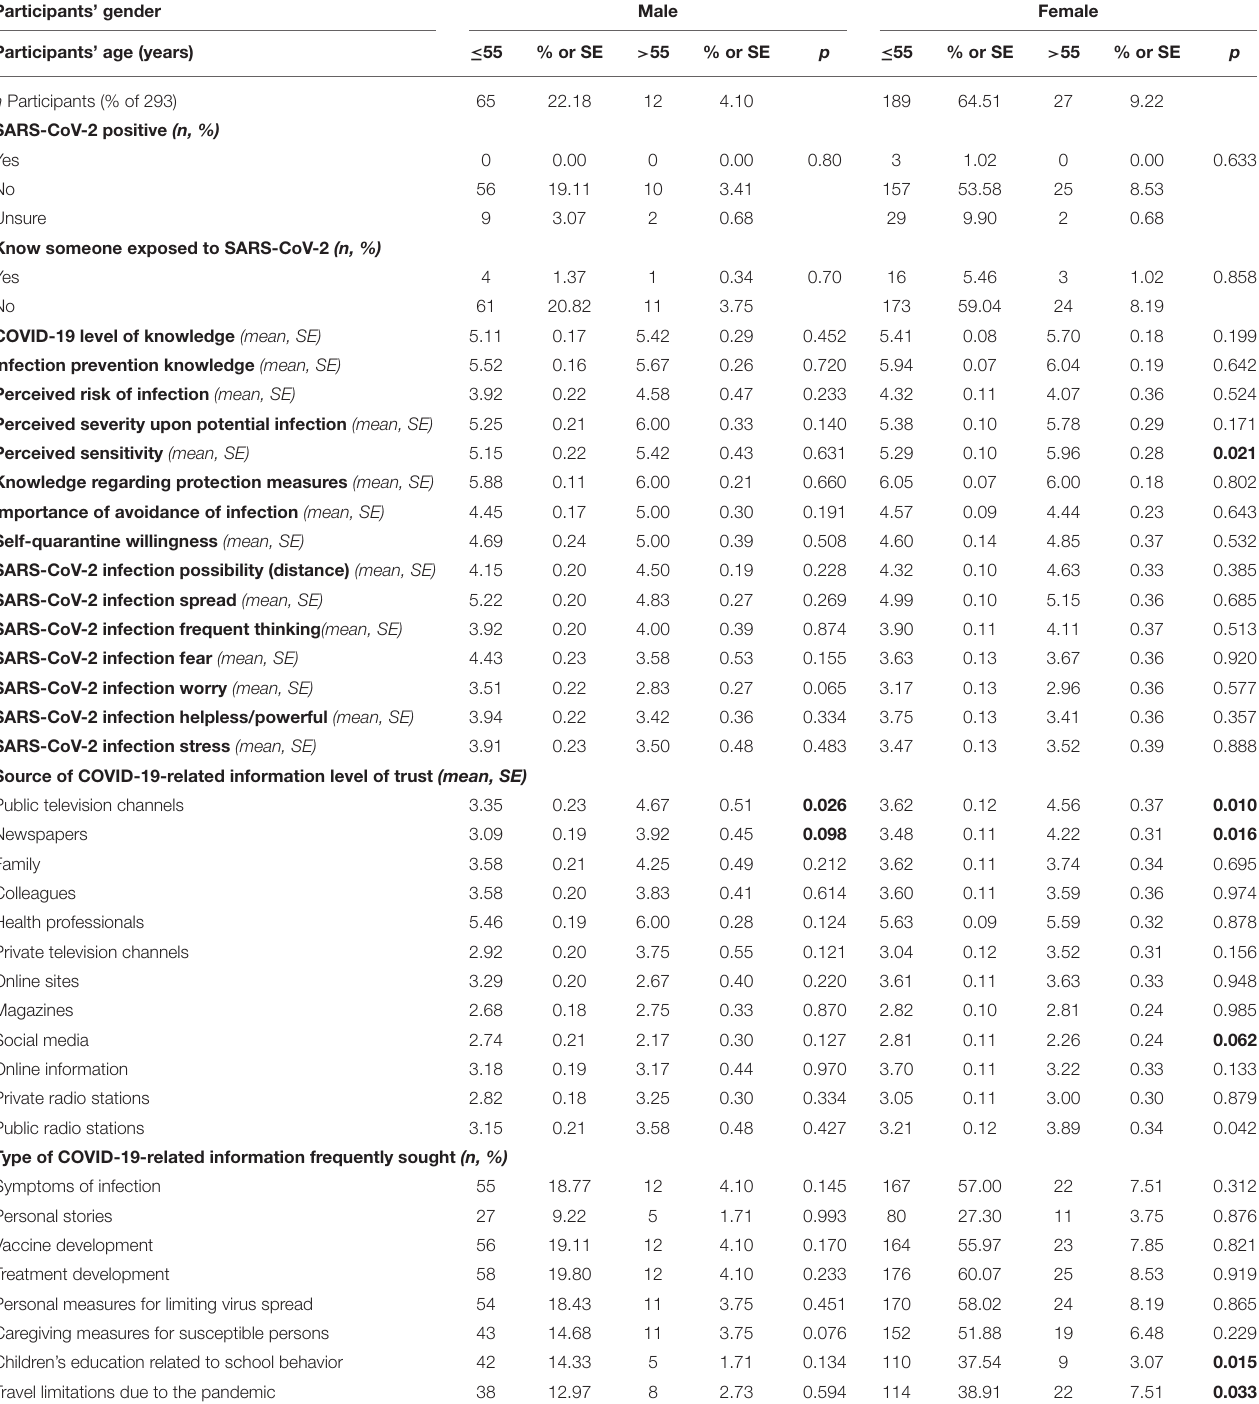
TABLE 3 | COVID-19-related behavior and beliefs. Participants’